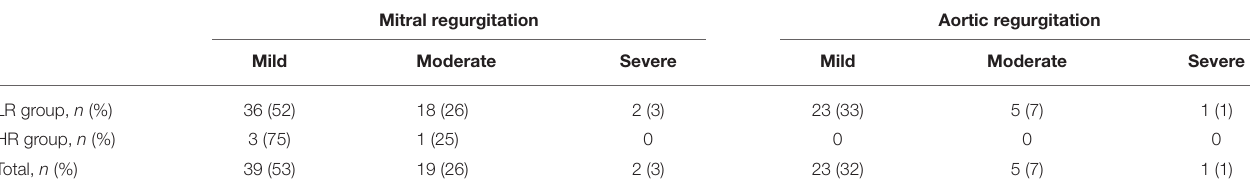
TABLE 4 | Echocardiographic findings of patients with cardiac